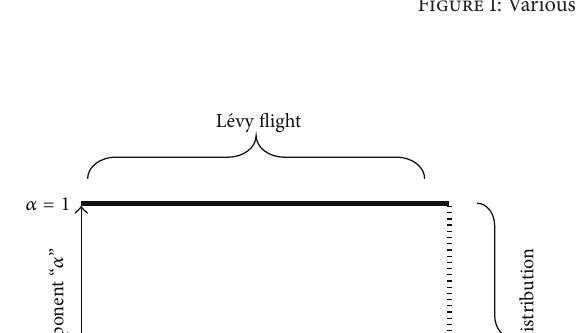
Figure 1: Various stages of firefly search.